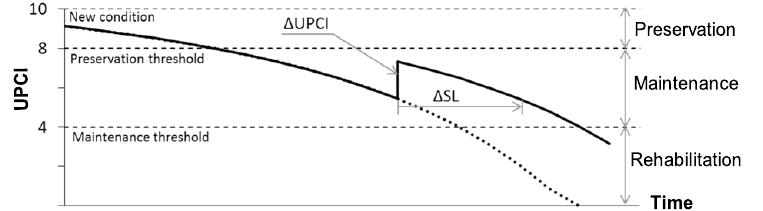
Fig. 1. Maintenance activities lead to an increase in pavement service life (Δ SL ) and, therefore, an immediate improvement in pavement condition (Δ UPCI ) at the moment of